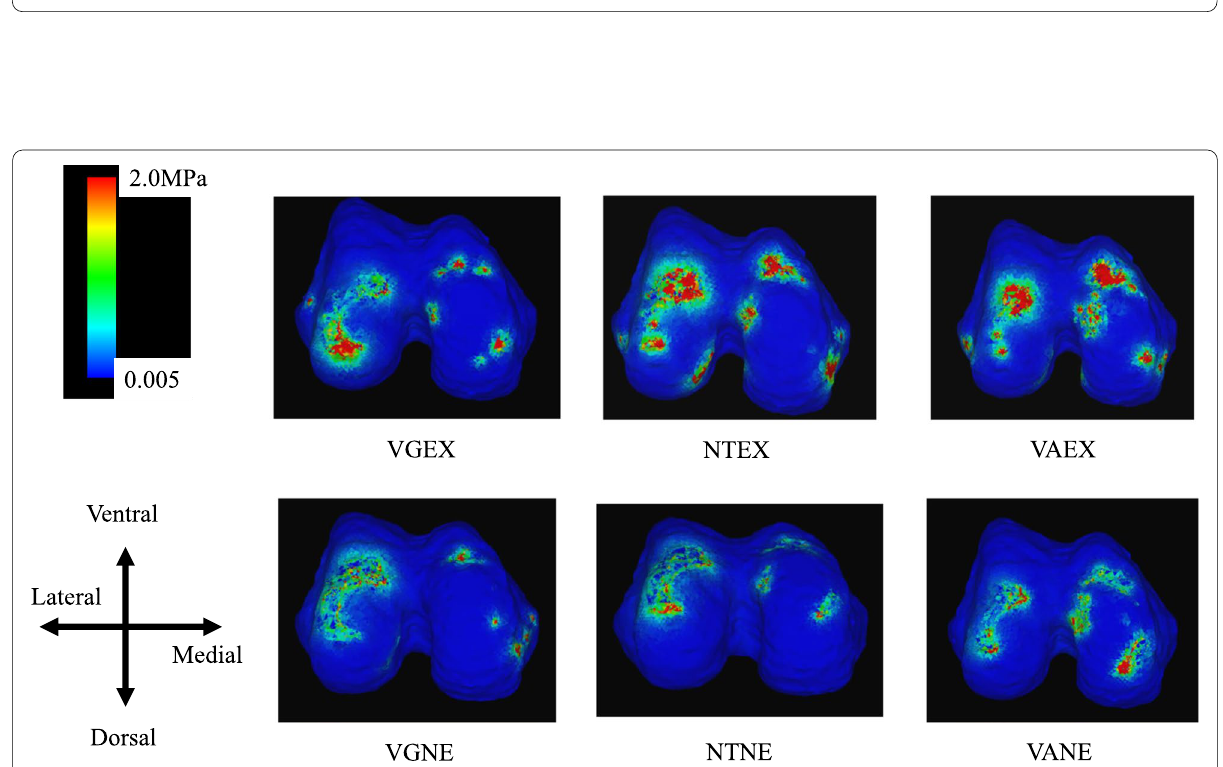
Fig. 4 Axial view of the knee cartilage on the femoral side showing von Mises stress. The von Mises stress was most increased in the medial cartilage on the femur side in the VAEX model, followed by the NTEX model. VGNE; valgus and non-extrusion of medial meniscus, VGEX; valgus and extrusion of medial meniscus; NTNE; neutral and non-extrusion of medial meniscus, NTEX; neutral and extrusion of medial meniscus, VANE; varus and non-extrusion of medial meniscus, VAEX; varus and extrusion of medial